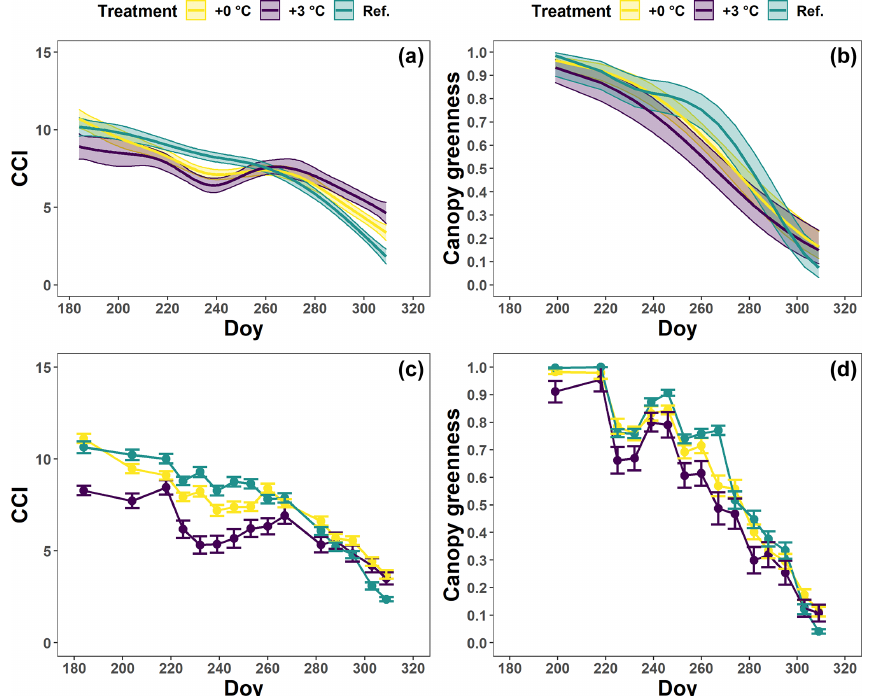
Figure 4. The generalized additive mixed model fits for the chlorophyll content index (CCI; a ) and loss of canopy greenness (b) of the Fagus sylvatica saplings at the Drie Eiken Campus in Wilrijk. The solid colored lines represent smooth terms, while the colored shaded bands around the smooth terms approximate the 95% simultaneous confidence intervals (a) and 95% pointwise confidence intervals (b) . The dots and error bars represent the mean CCI (c) and mean canopy greenness (d) with standard errors. The colors represent the CCI or the loss of canopy greenness of the beech saplings in the reference plots (green; Ref.), the glasshouses that followed the outside ambient air temperature (yellow; + 0 ◦ C) and the glasshouses that were 3 ◦ C warmer than the outside ambient air temperature (purple; + 3 ◦